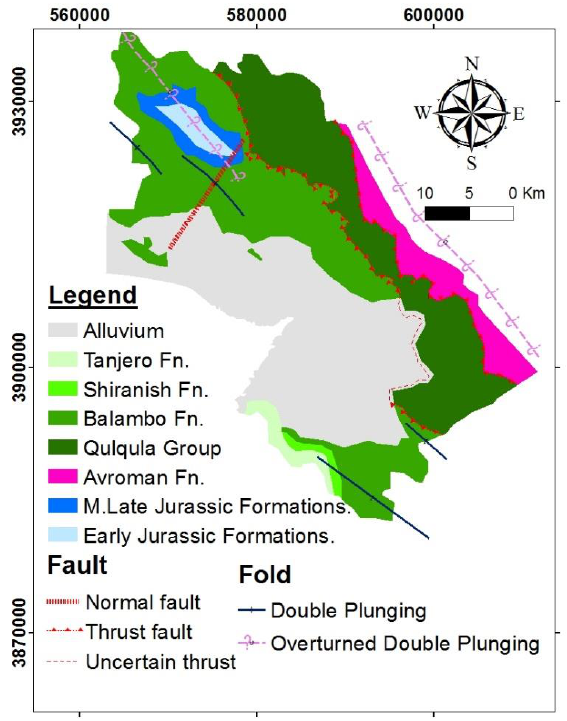
Figure 2. Geological map of the HSB, modified from [2–15].